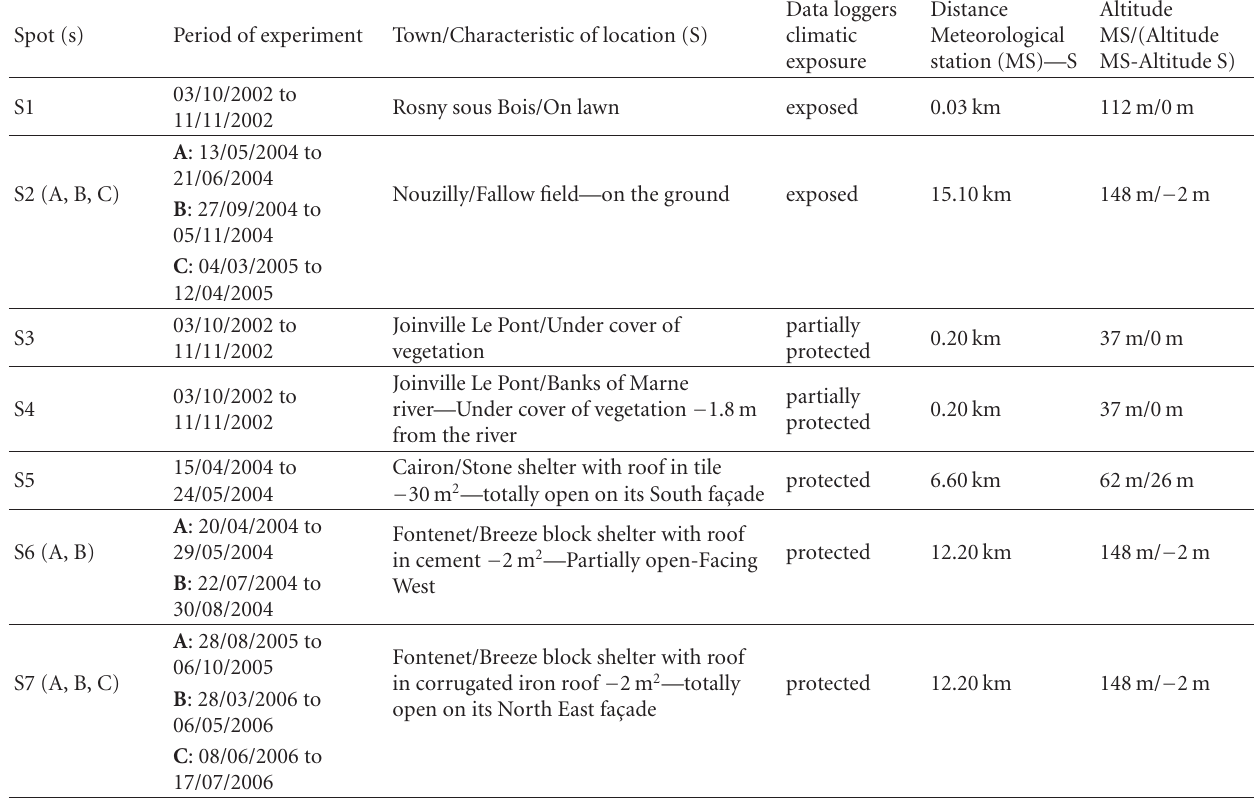
Table 1: Characteristics of the sites and data loggers’ climatic exposure; comparison with their meteorological station associated (A, B, or C: periods of experimentation for a same